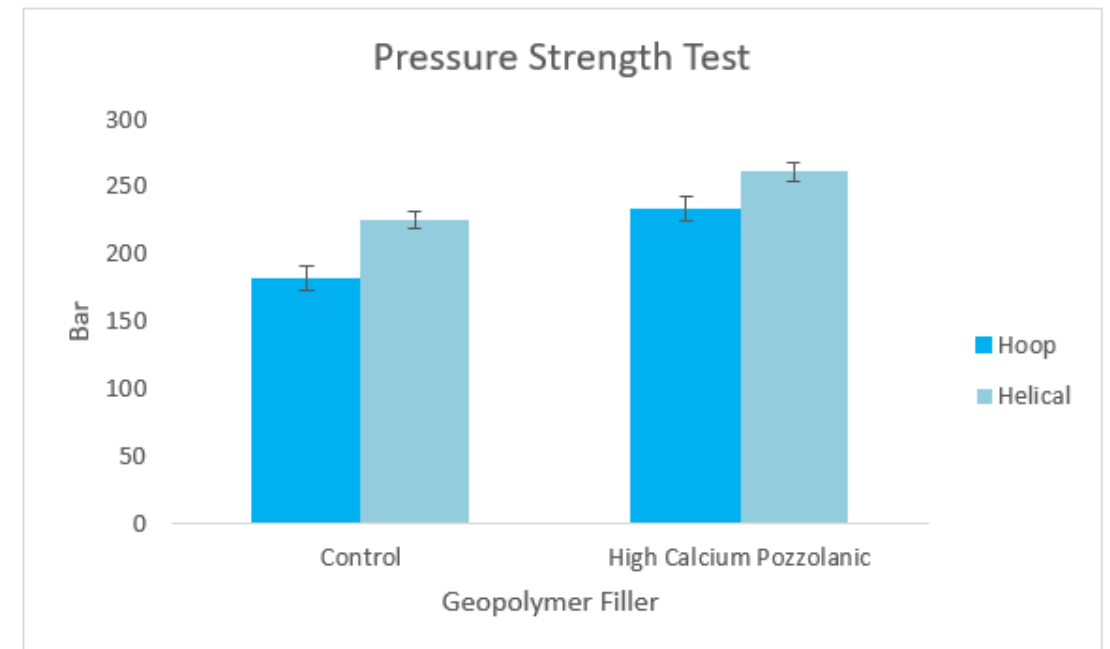
Figure 13. Burst test of the control sample and GRE filled with high calcium pozzolanic-based geo- polymer pipe. geopolymer